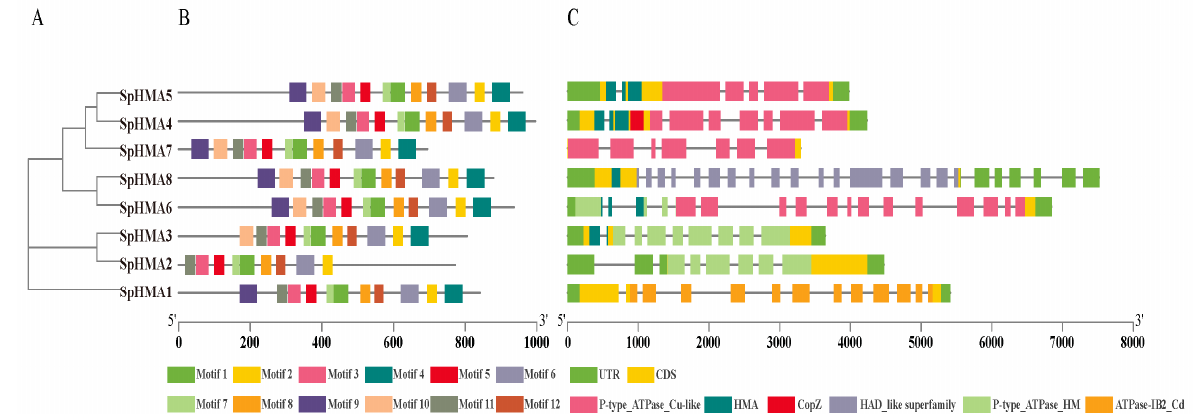
Figure 3. Phylogenetic relationships, motif compositions and gene structure of HMA genes in